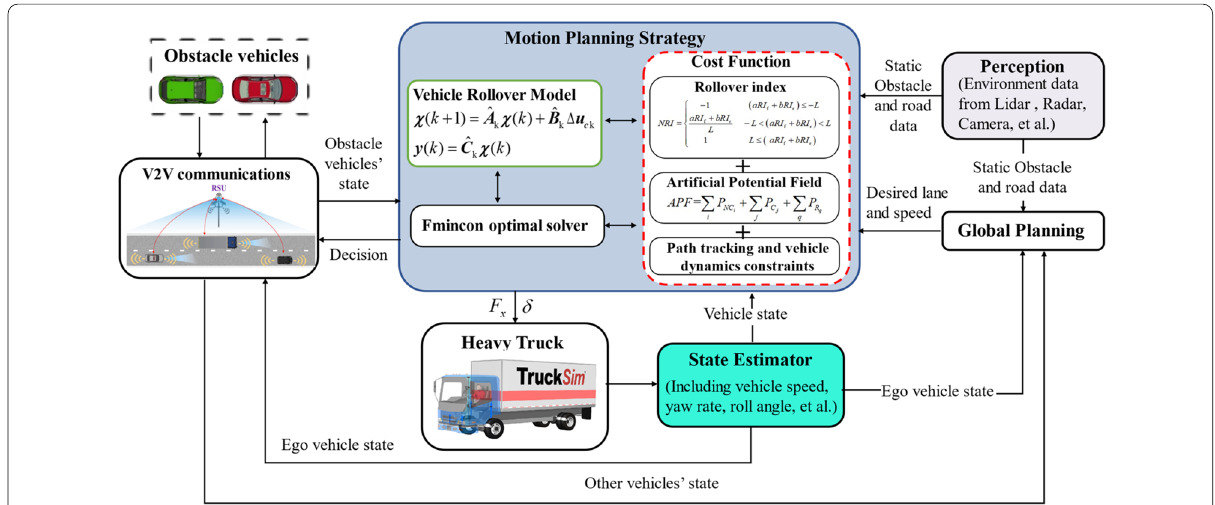
Figure 1 The framework of the intelligent heavy truck motion